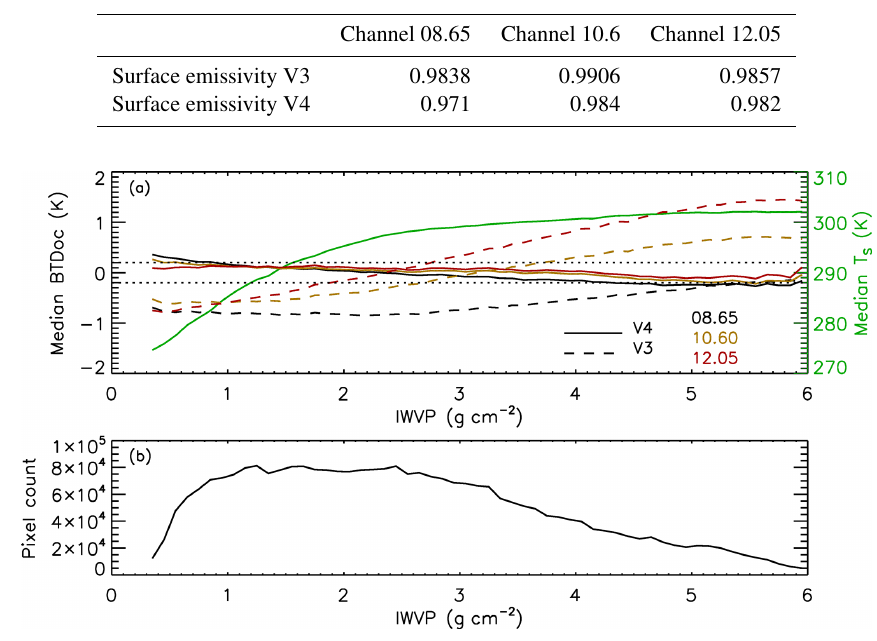
Figure 2. (a) Median difference between observed and computed brightness temperatures (BTDoc) at 08.65µm (black), 10.6µm (brown), and 12.05µm (red) vs. MERRA-2 IWVP in V4 pristine (no cleared clouds) nighttime clear-sky conditions in V4 (solid lines) and in V3 (dashed lines) over oceans between 60 ◦ S and 60 ◦ N from July through December 2006. The horizontal dotted lines denote the − 0 . 2 and + 0 . 2K limits. Overplotted in green is the median MERRA-2 surface temperature; (b) number of IIR